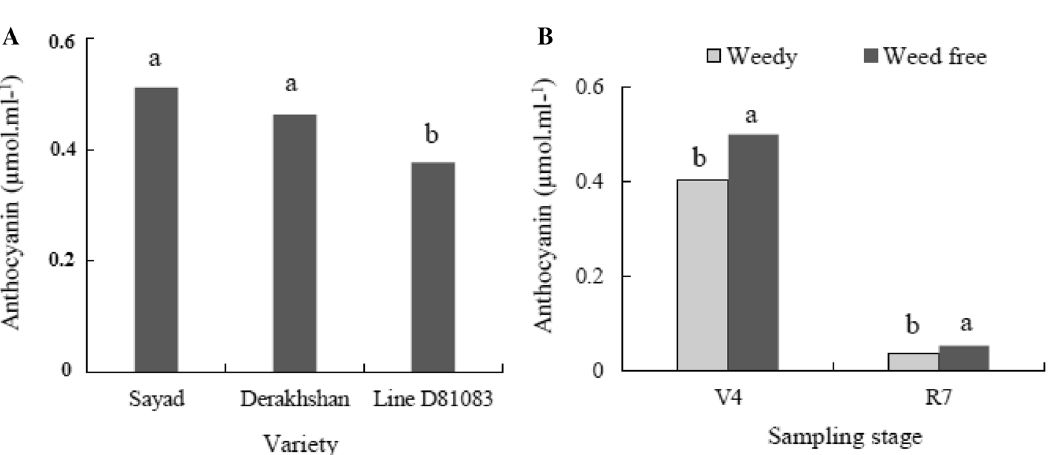
Figure 11. The anthocyanin content in the three cultivars/lines ( A ) and two treatments weedy and weed free and in two stages of sampling V4 and R7 ( B signal transmission system. The reflected R/FR ratio can act as a warning signal, informing the plants about the increased risk of photon inhibition and oxidative stress 44 . Under FR-rich conditions, changes in the content of photosystem elements (PS) lead to the production of ROS as well as antioxidant responses. According to a study by Mckenzie-Gopsill et al. 18 , weed-filled treatment significantly increased H 2 O 2 levels in monocotyledonous